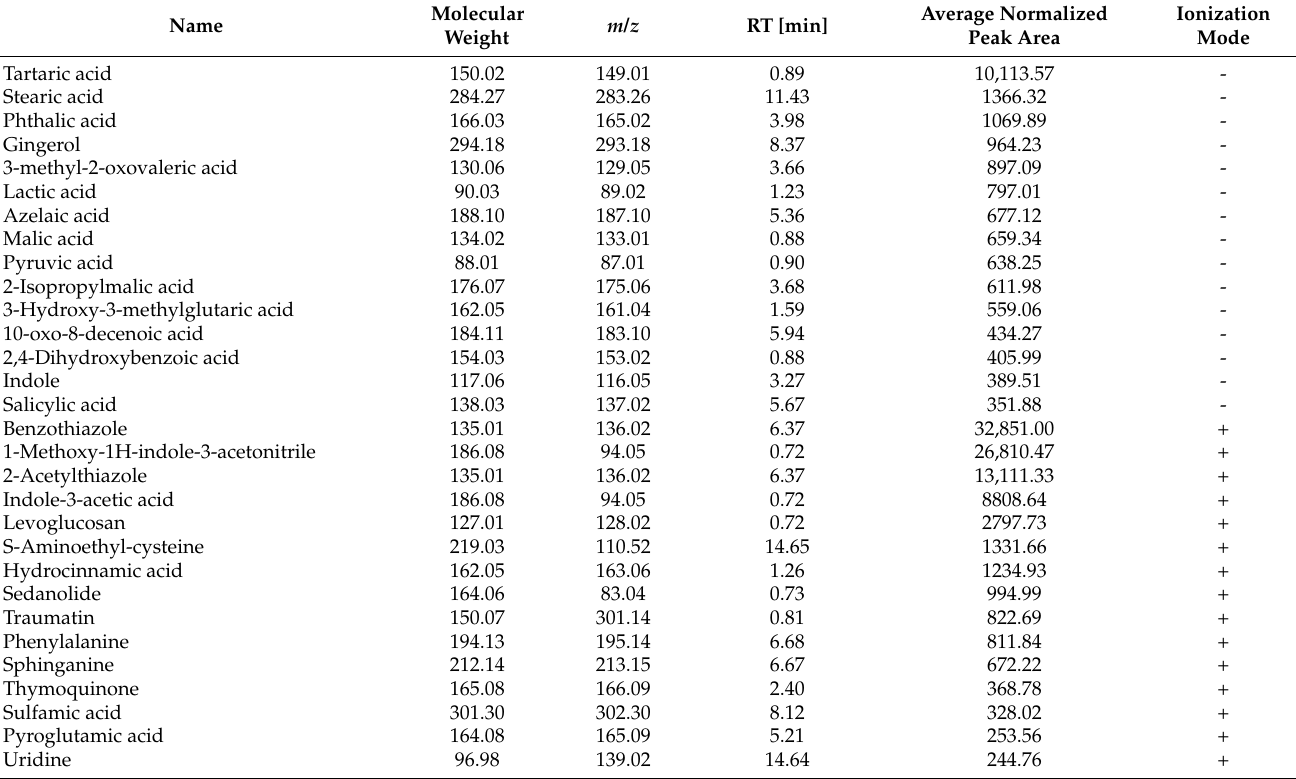
Table 1. Top 30 compounds identified in NFX-FRZ exudates (15 from each of negative and positive ionization